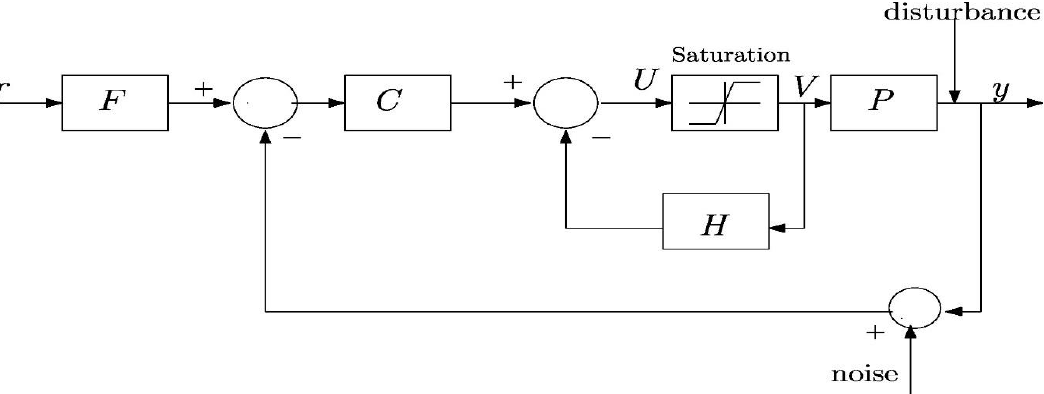
Figure 2. An interacting 3-DOF control structure.